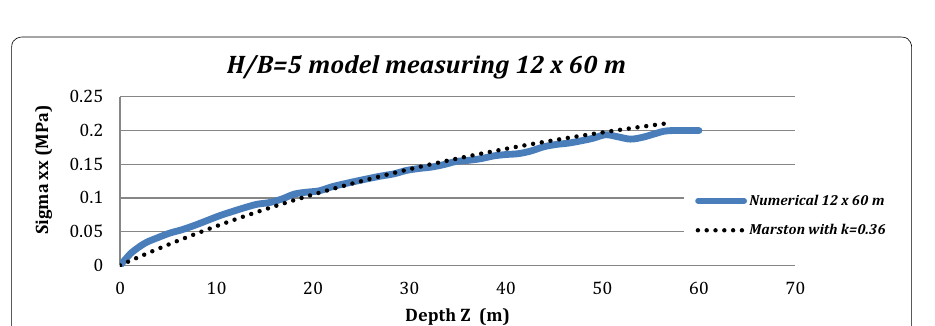
48 m (H/B 4); K 0.37. Geome- × = = 300 MPa, c 0 = =